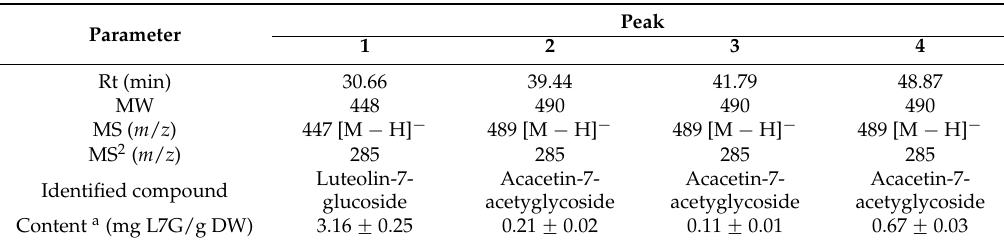
Table 3. Content and mass spectrum data of the identified phenolic compounds in the purified SGslP